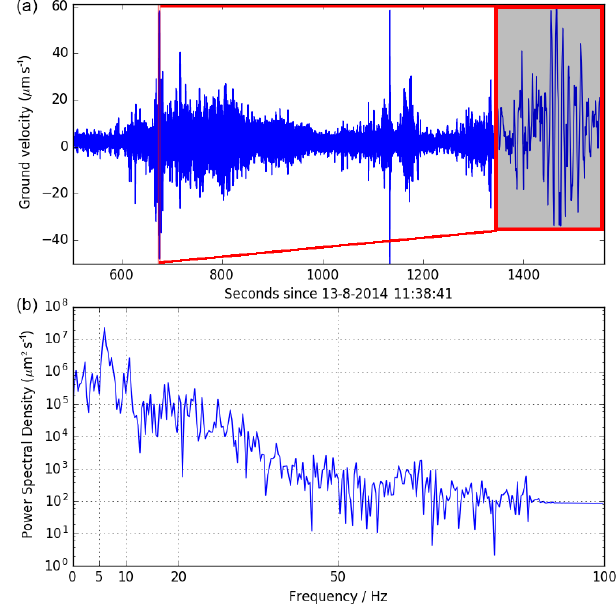
Figure 10. A typical power spectrum for a calving event (13 Au- gust 2014), for a 3s time window containing the highest peak ampli- tude of the event. The shaded inset in the top panel shows a zoomed- in view of this